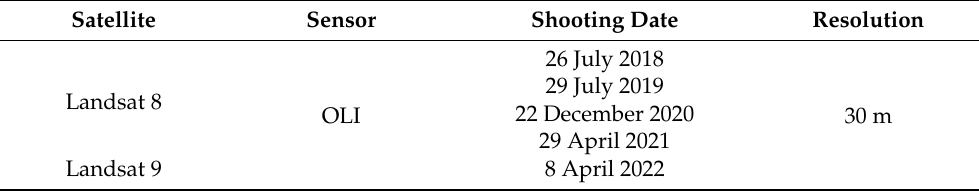
Table 1. The technical indicators of Landsat images that were used in this study.